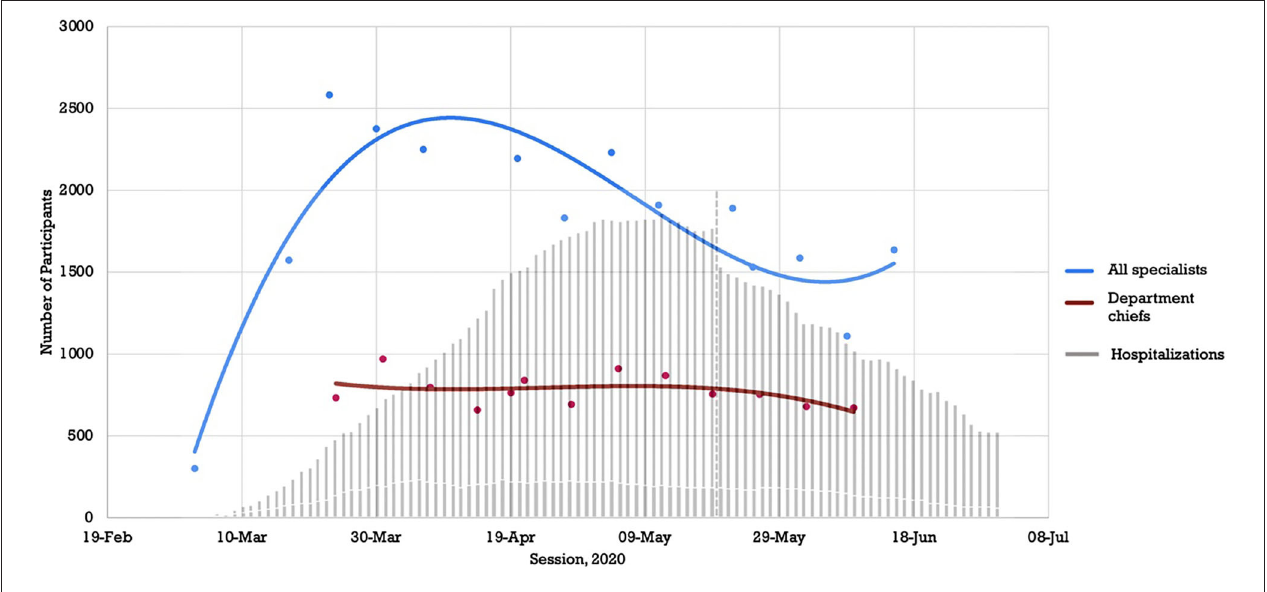
FIGURE 2 | Attendance vs. Hospitalizations in Quebec over Time.